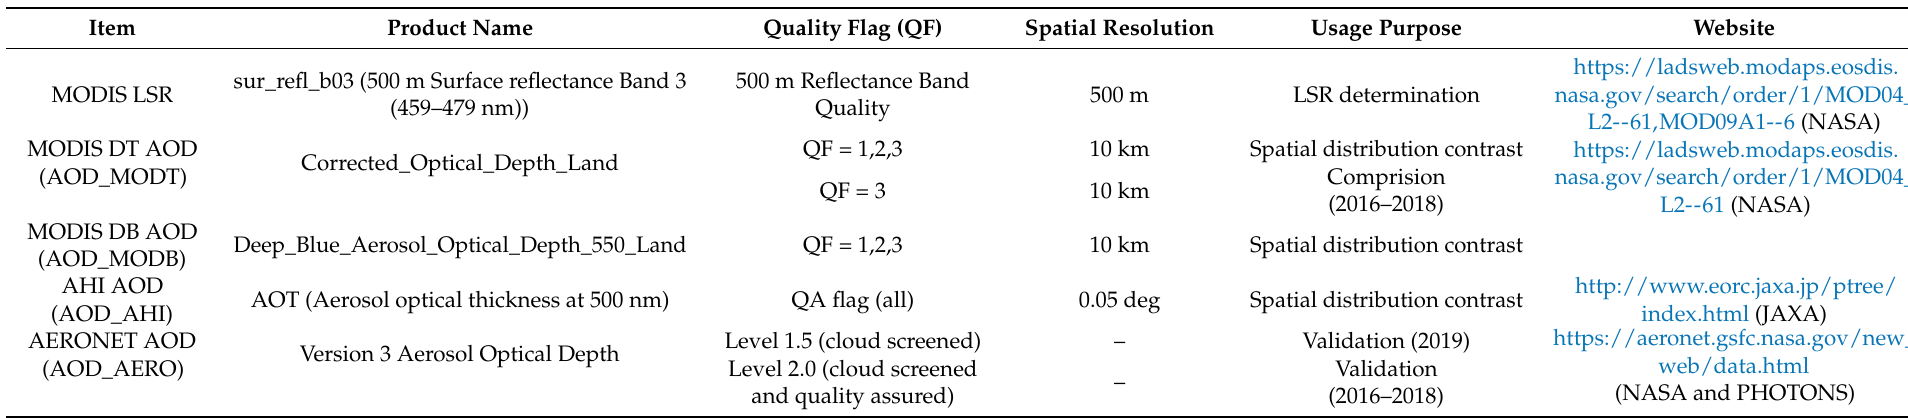
Table 2. MODIS, AHI, and AERONET products used in this